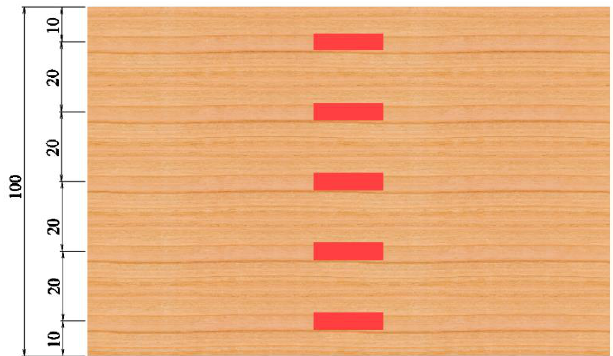
Figure 7. The location of the strain gauges.